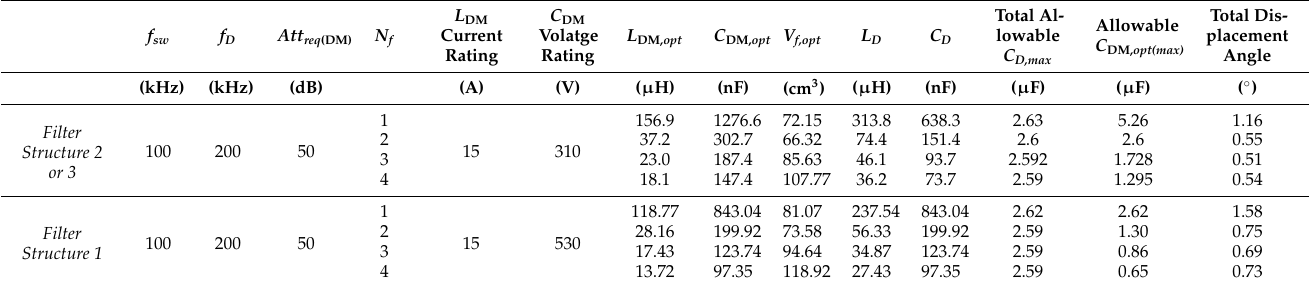
Table 1. Optimized DM Filter Component Values for N f = 1 to 4.